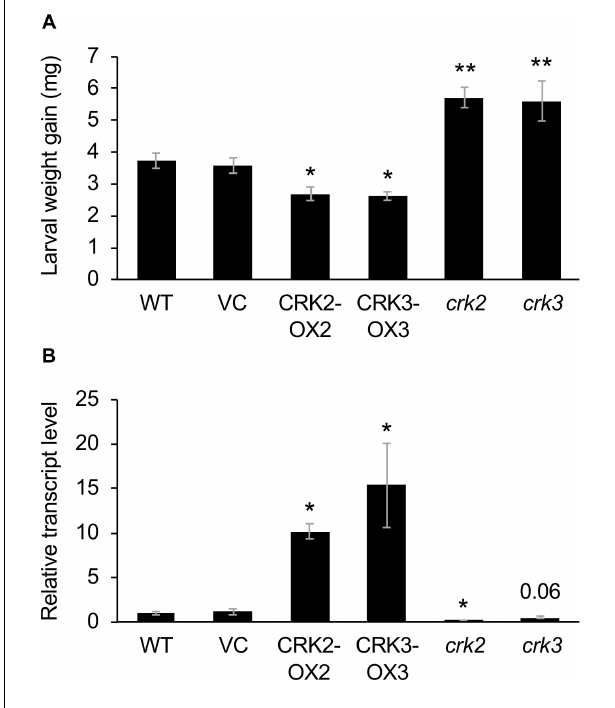
FIGURE 3 | Defense property of wild type (WT), crk mutants, and CRK-overexpressing lines. (A) The net body weight that Spodoptera litura larvae gained during 3 days after they had been placed on potted plants of WT, crk2 , or crk3 mutants, CRK-overexpressing lines (CRK2-OX2 and CRK3-OX3) and their vector control (VC) lines. Data represent the mean and standard error ( n = 16–22). (B) Transcript levels of a defensin gene PDF1.2 in the leaves of WT, crk mutants, CRK-overexpressing plants, and VC plants. Transcript levels of genes were measured by RT-qPCR and normalized by those of ACT8 . Data represent the mean and standard error ( n = 4 for VC, CRK2-OX2, and CRK3-OX3; n = 7 for WT, crk2 , and crk3 ). Data marked with an asterisk are significantly different from those of WT (A) or VC (B) , based on a one-way ANOVA with Holm’s sequential Bonferroni post hoc test ( ∗∗ P < 0.01, ∗ 0.01 ≤ P < 0.05). Otherwise, the mean followed by P value is marginally different from the control